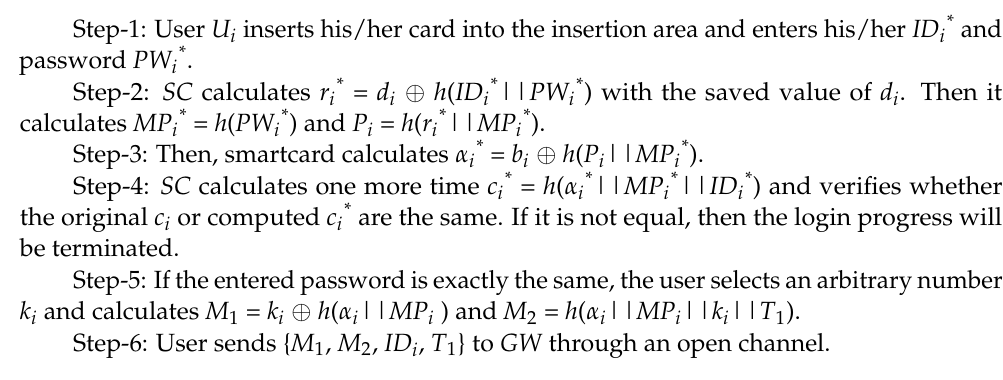
Figure 3. Login phase of Singh et al.’s scheme.